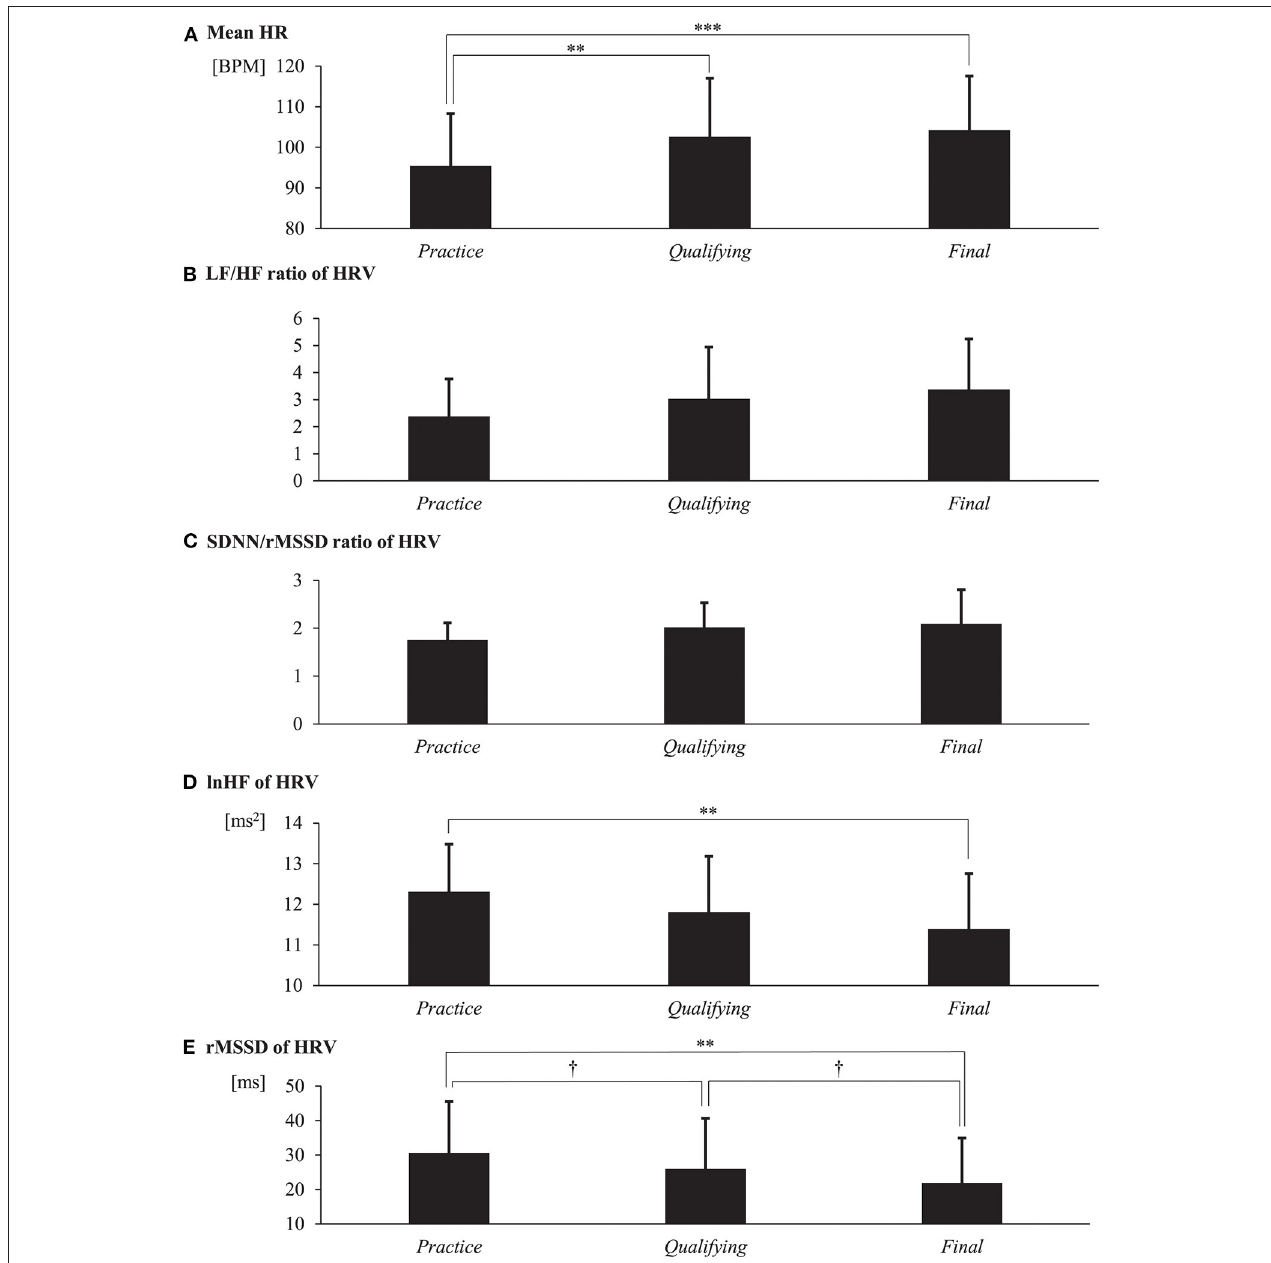
FIGURE 1 | Physiological data obtained during different sessions . (A) Mean heart rate (HR). (B) The ratio of the low-frequency component to the high-frequency component (LF/HF ratio) of the heart rate variability (HRV). (C) The ratio of the standard deviation of all R–R intervals to the root mean square of successive differences of R–R intervals (SDNN/rMSSD ratio) of the HRV. (D) The logarithm of the HF (lnHF) component of the HRV. (E) The rMSSD of the HRV. Data are presented as the mean ± standard deviation. The Holm’s method was employed for post hoc testing. Statistical significance of differences is indicated as follows: † p < 0.1, ** p < 0.01, *** p <